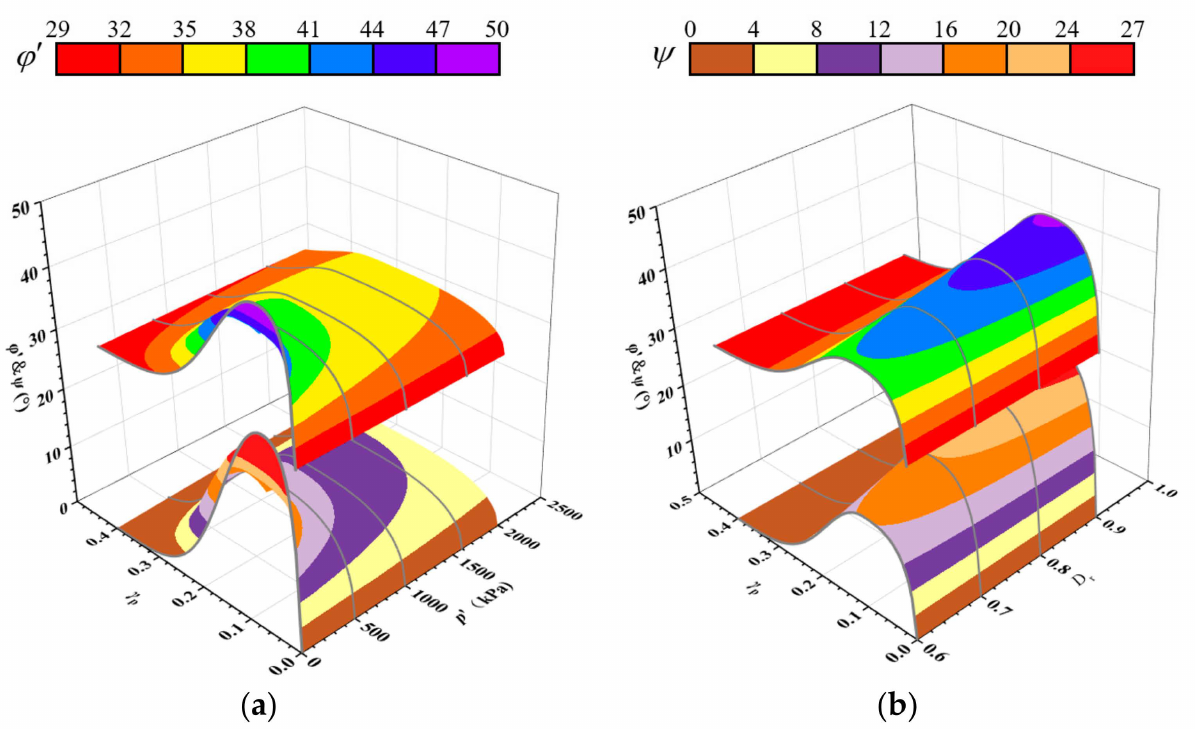
Figure 4. Variationsinmobilizedfrictionangleanddilationanglewithplasticshearstrain( ϕ (cid:48) confining pressures with D r = 90%; ( b ) various relative densities with p ’= 40